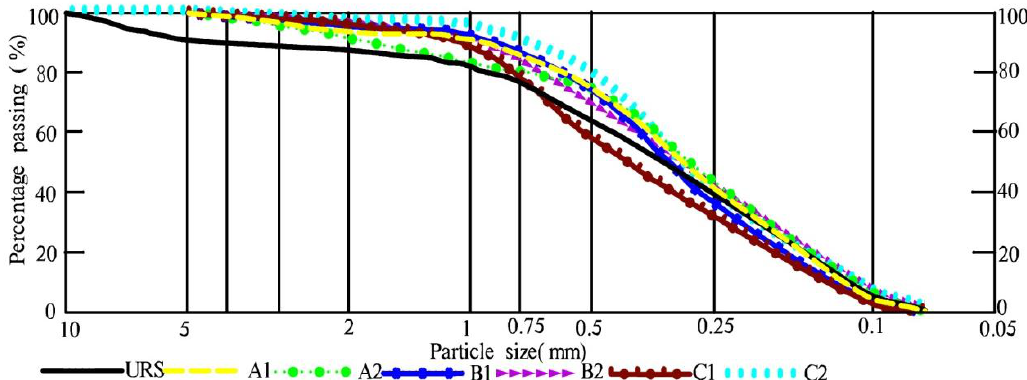
Figure 14. Accumulative curve of particle gradation of soil at the sampling depth of 10 cm.